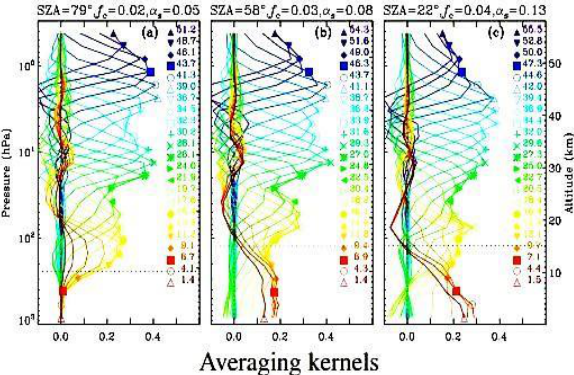
Figure 5 - Effect of changes of the angle of the Solar Zenith on the estimation of the ozone in OMI instrument